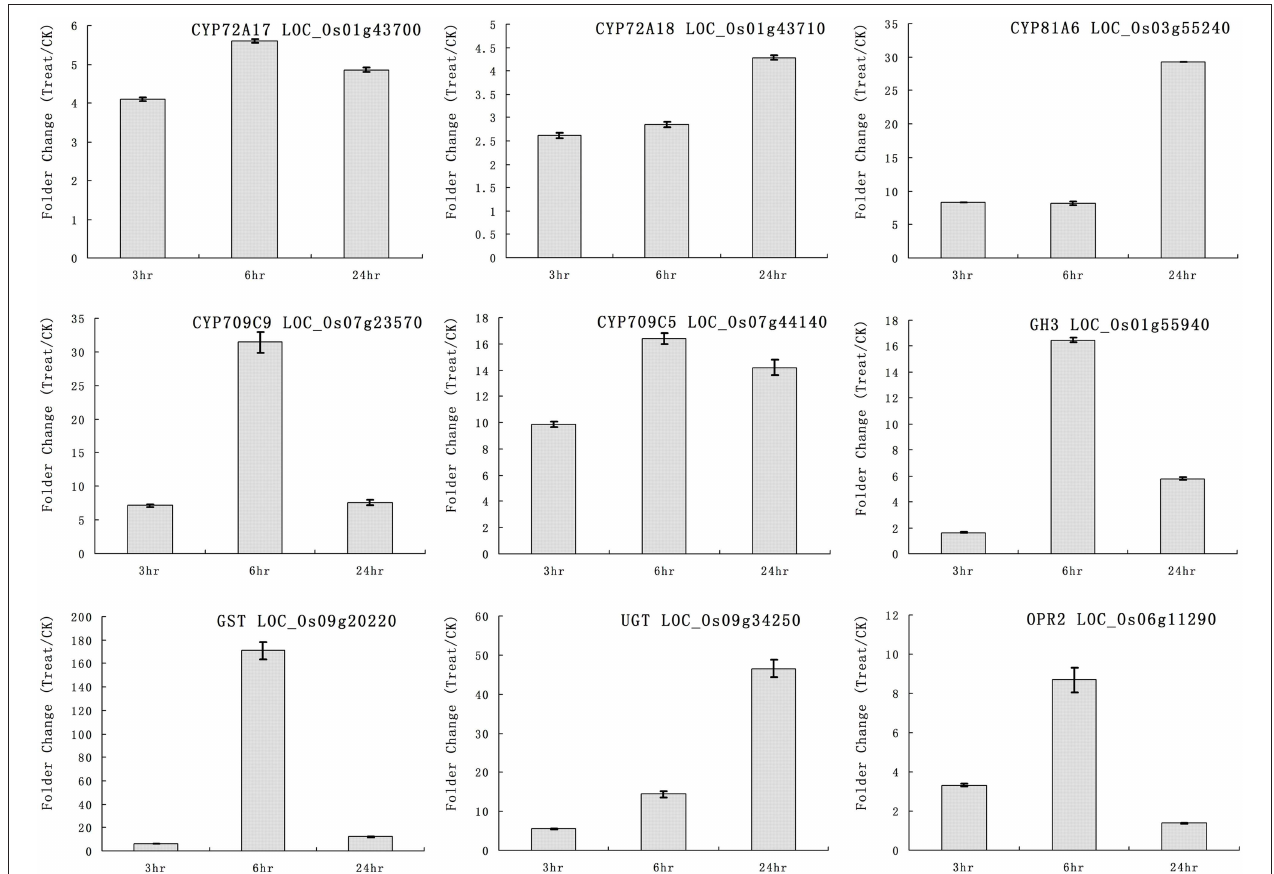
FIGURE 3 | The expression pattern of selected rice genes responded to different times of quinclorac treatment. The expression values were detected by real-time RT-PCR. The gray bars indicate the fold change of the gene between quinclorac treatment and mock; the error bars represent the standard error of three replicates. LOC_Os01g43700—CYP72A17; LOC_Os01g43710—CYP72A18; LOC_Os03g55240—CYP81A6; LOC_Os07g23570—CYP709C9; LOC_Os07g44140—CYP709C5; LOC_Os01g55940—GH3; LOC_Os09g20220—GST; LOC_Os09g34250—UGT;